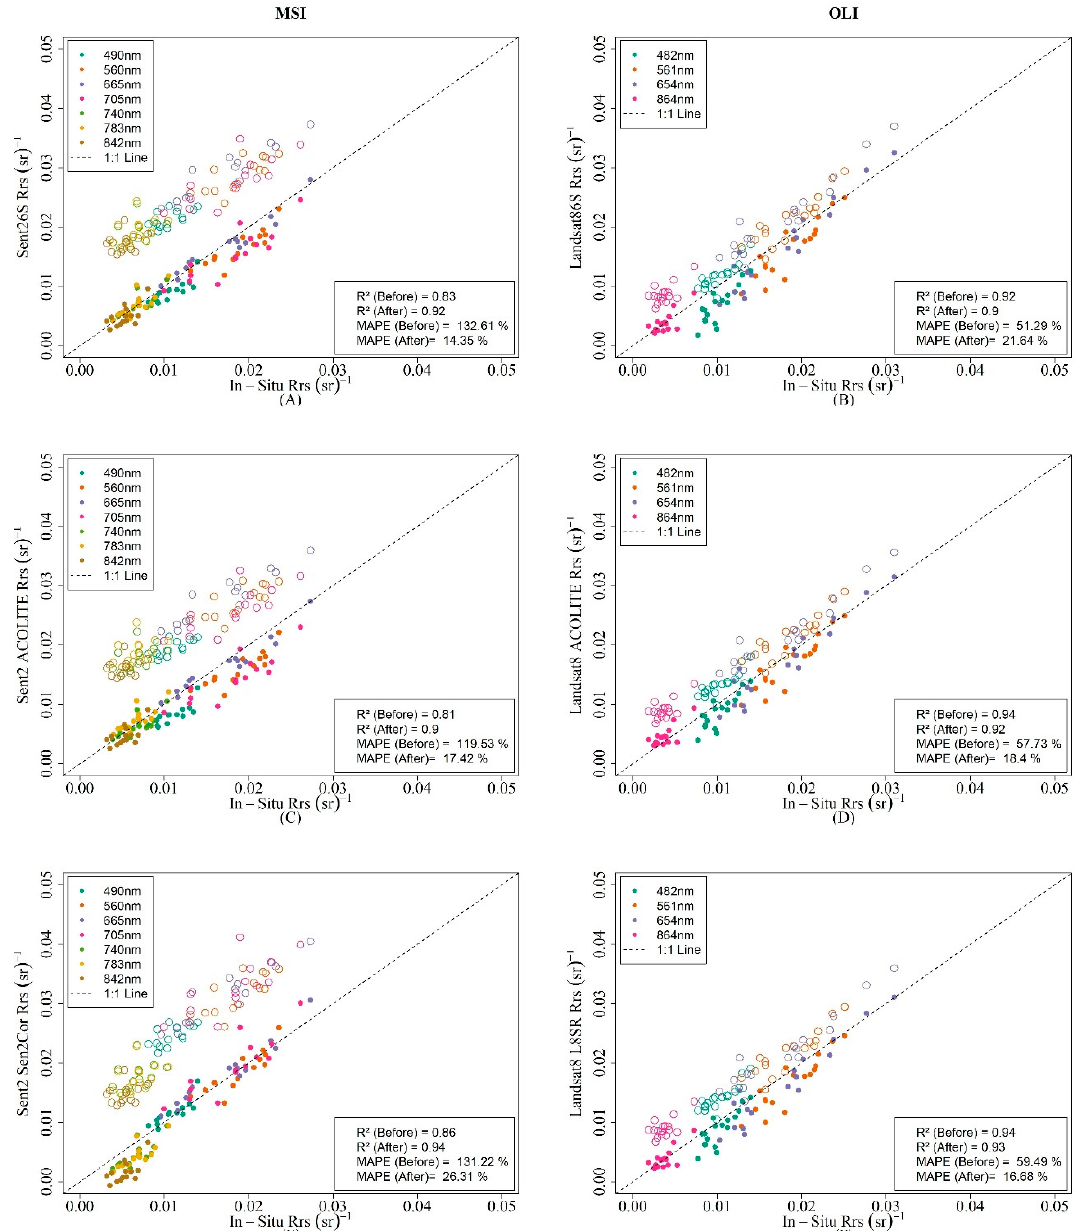
Figure 9. The atmosphere correction results before (empty circles) and after (fill circles) glint correction for both sensors (Point colors refer to sensor spectral bands—see the top-left box). The R 2 and MAPE values for the right-bottom box refers to the atmospheric correction results before and after glint correction for all VNIR bands. The left column refers to the MSI methods: 6S ( A ), ACOLITE ( C ), and Sen2Cor ( E ) and the right column refers to the OLI methods: 6S ( B ), ACOLITE ( D ), and L8SR ( F